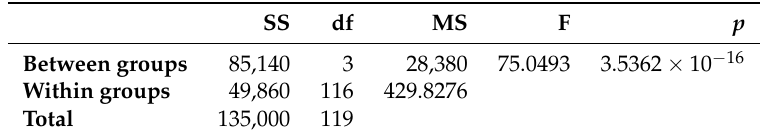
Figure 5. Task 2-user preference level in single-click actions using four different haptic technologies: ( a ) distribution per treatment, ( b ) mean and standard deviation, ( c ) evaluation function of users’ age. Table 1. Kruskal Wallis test for Task2.